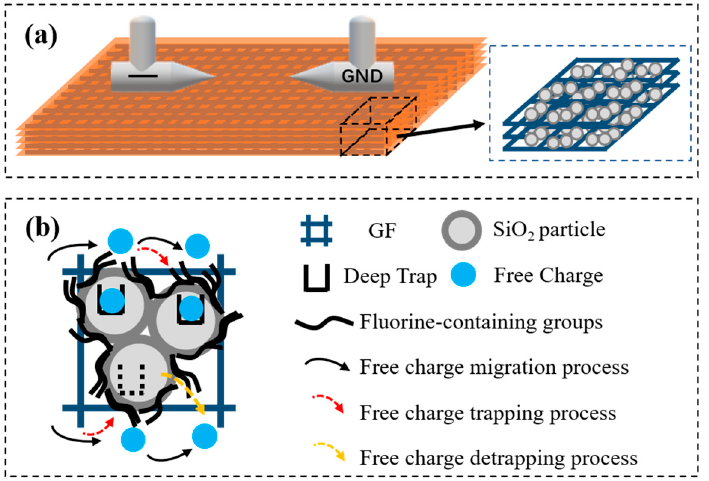
Figure 10. Schematic diagram of charge transport mode. ( a ) schematic diagram of modified GFRP structure. ( b ) influence mechanism of trap on charge transport.